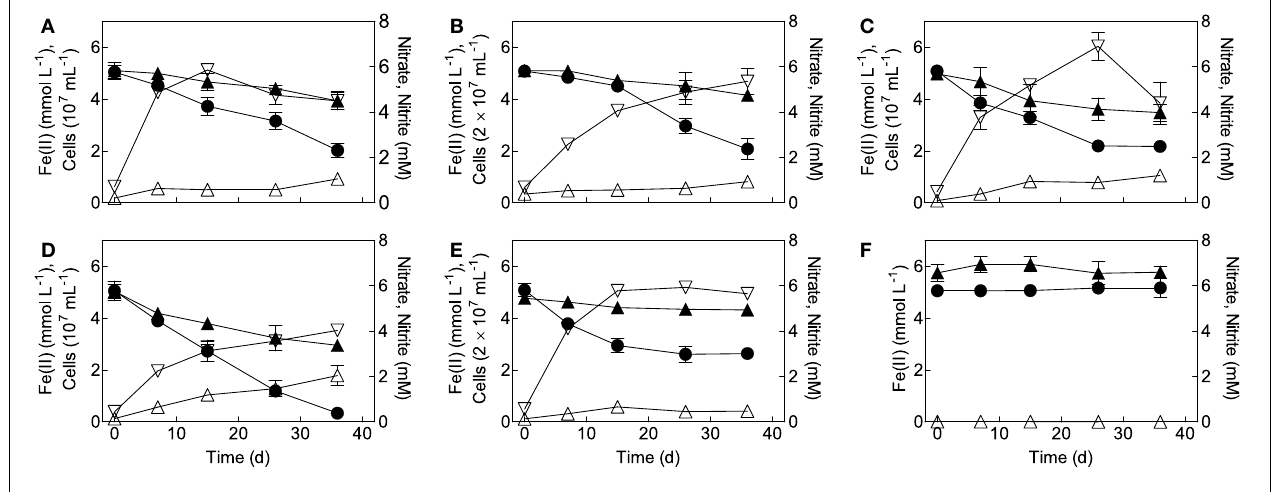
FIGURE 3 | Growth of mixotrophic Fe(II)-oxidizing isolates on reduced NAu-2 smectite with nitrate as the electron acceptor. (A) Bradyrhizobium sp. strain in8p8; (B) Bradyrhizobium sp. strain bis5; (C) Cupriavidu necator